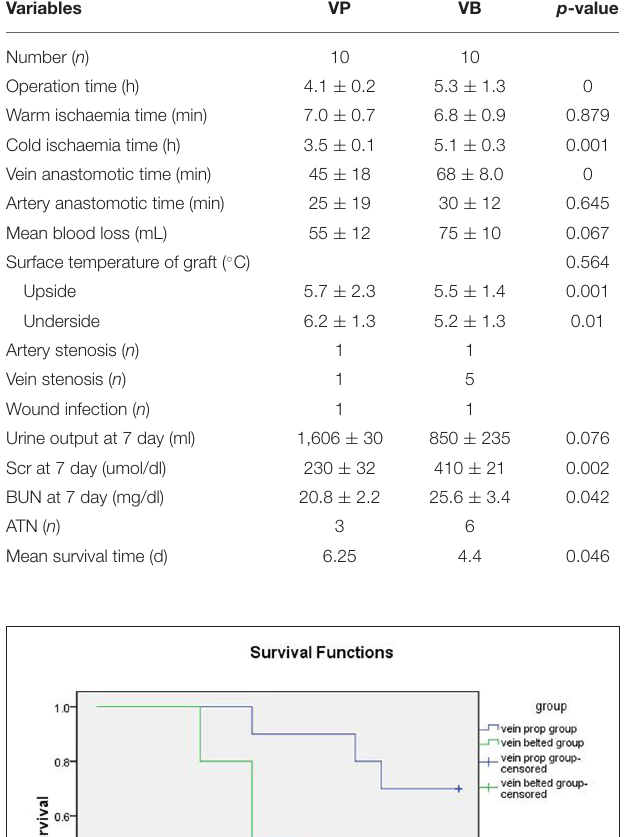
TABLE 1 | The observational data from the two groups.